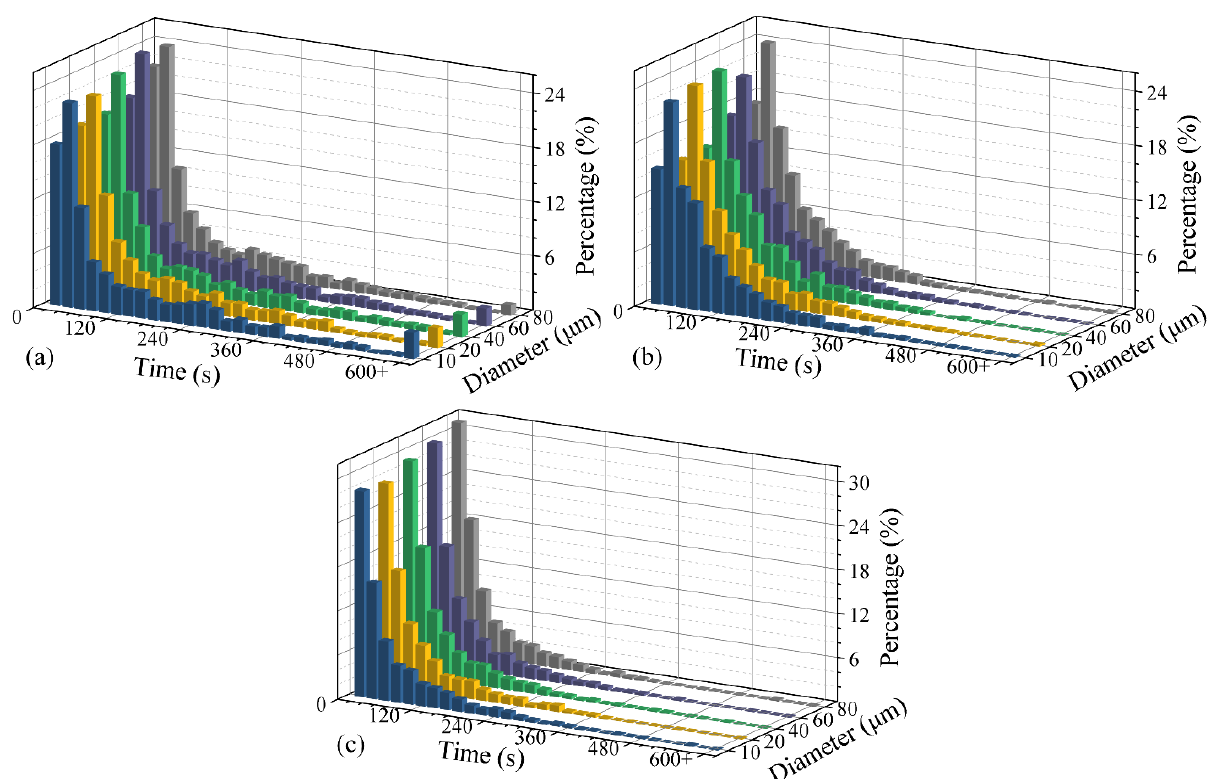
Figure 18. Floating efficiency of inclusions in distributing chamber. ( a ), ( b ) and ( c ) are the results of tundishes A, B and C, respectively.